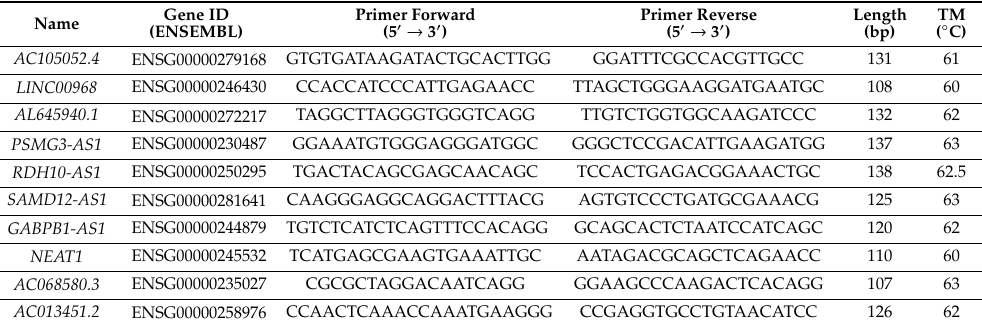
Figure 3. qRT-PCR validation of chosen di ff erentially expressed lncRNAs. Histograms report the mean expression values ( n of replicate for each group = 6) of nine chosen di ff erentially expressed lncRNAs produced by qRT-PCR experiments, obtained after application of 2 – ∆∆ Ct method, normalized to the best stable lncRNA GABPB1-AS1 (not shown) and control group. Obtained results were statistically significant (ANOVA Bonferroni-corrected * p -values < 0.01). Table 1. List of primers used for qRT-PCR of 10 selected lncRNAs. Table shows features of primers used for qRT-PCR validation of ten selected